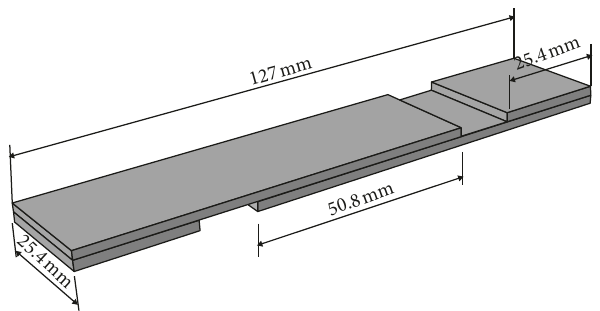
Figure 3: Shear specimens drawing.